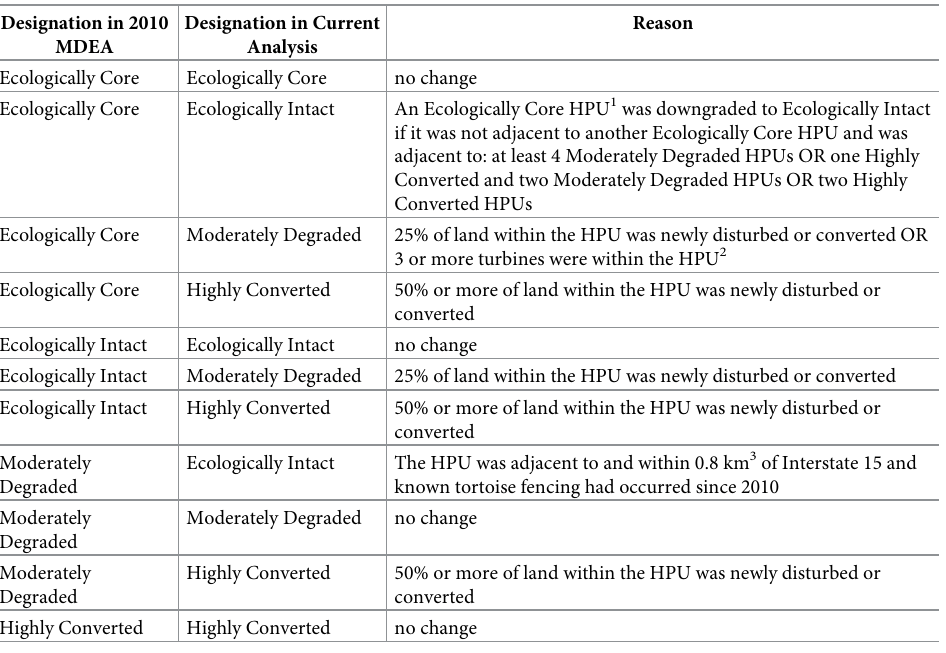
Table 3. Decision rules for conservation value